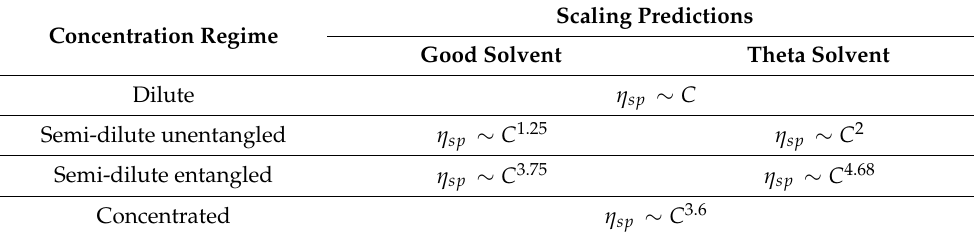
Table 1. Summary of scaling predictions between concentration and η sp (specific viscosity) in different concentration